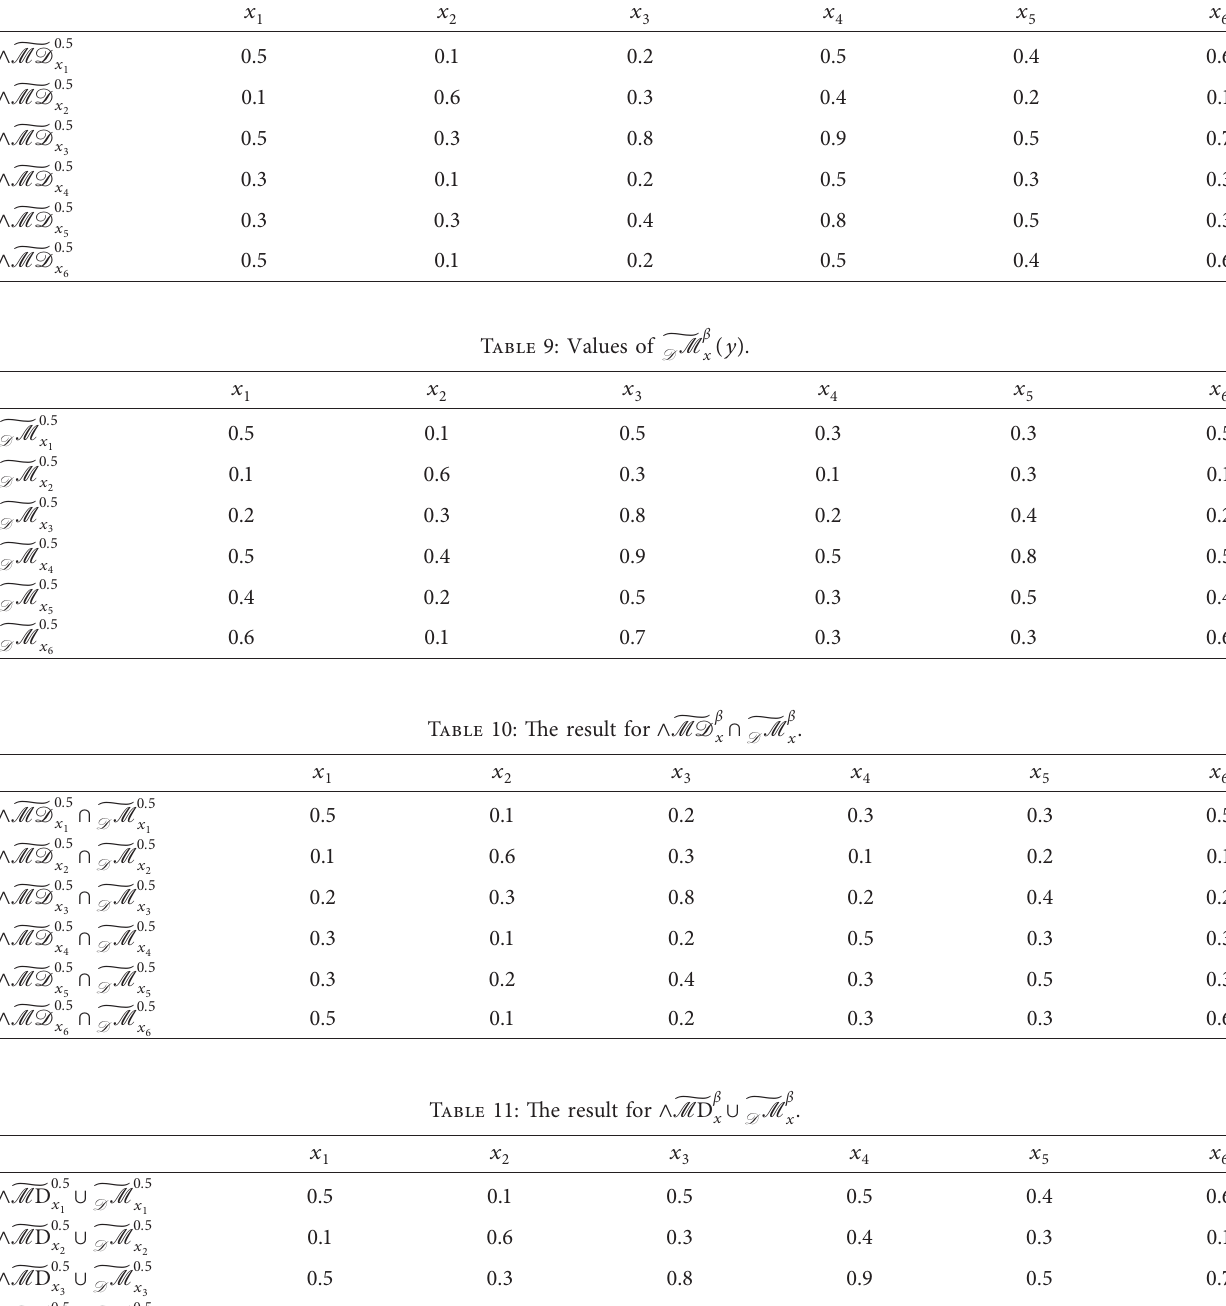
Table 8: Values of ∧ 􏽧 MD β